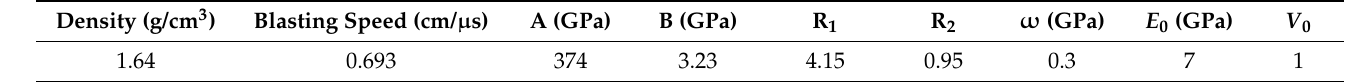
Table 2. Main parameters of the explosives in the explosive blasting test.